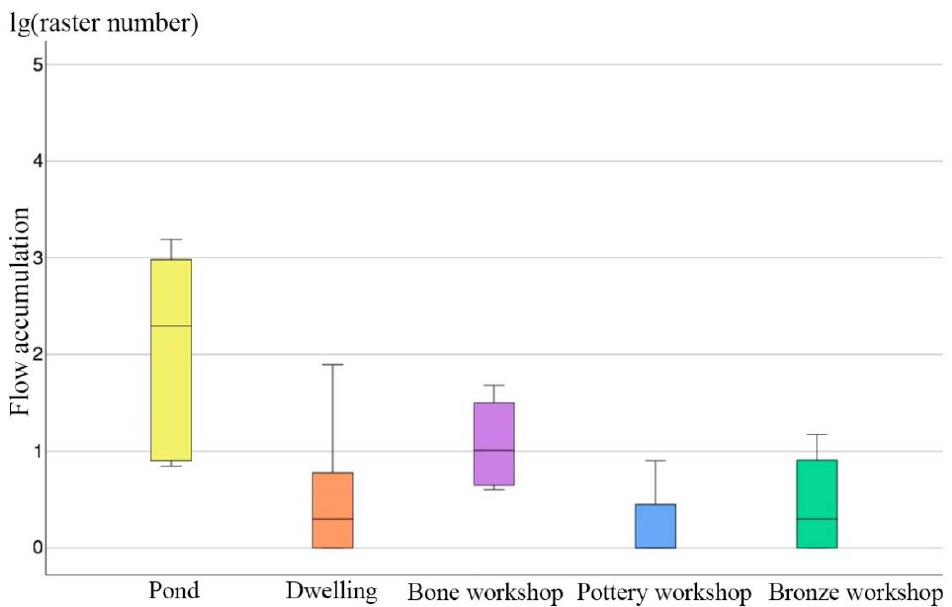
Figure 5. Flow accumulation of different types of archaeological features at Yinxu. Values were processed with a logarithm.